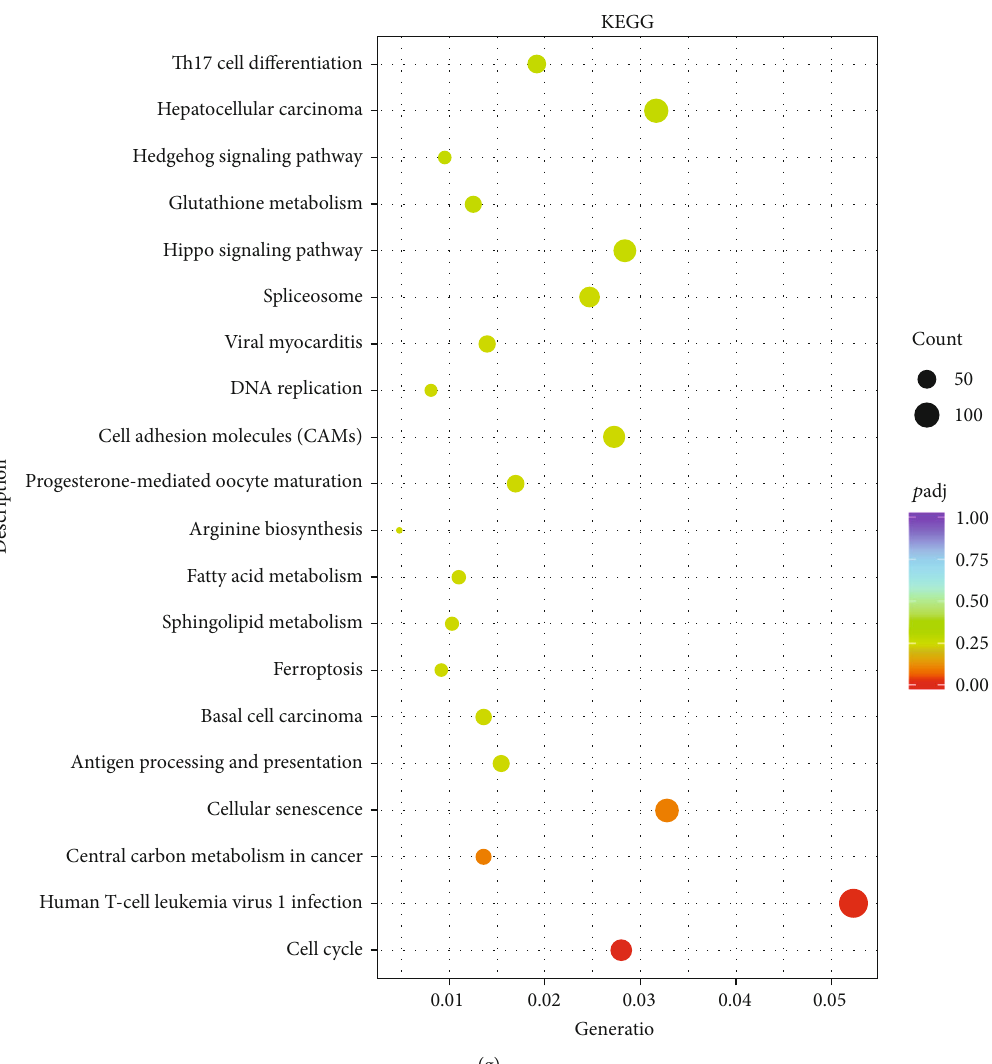
Figure 3: RNA sequencing results. (a) Volcano map. (b) The mRNA expression levels between samples. (c, d) Lgr4, Lgr5, Wnt4, and Wnt8a expression levels in RNA sequencing and qRT-PCR, respectively. (e, f, g) GO, Reactome, and KEGG bioinformatic analysis